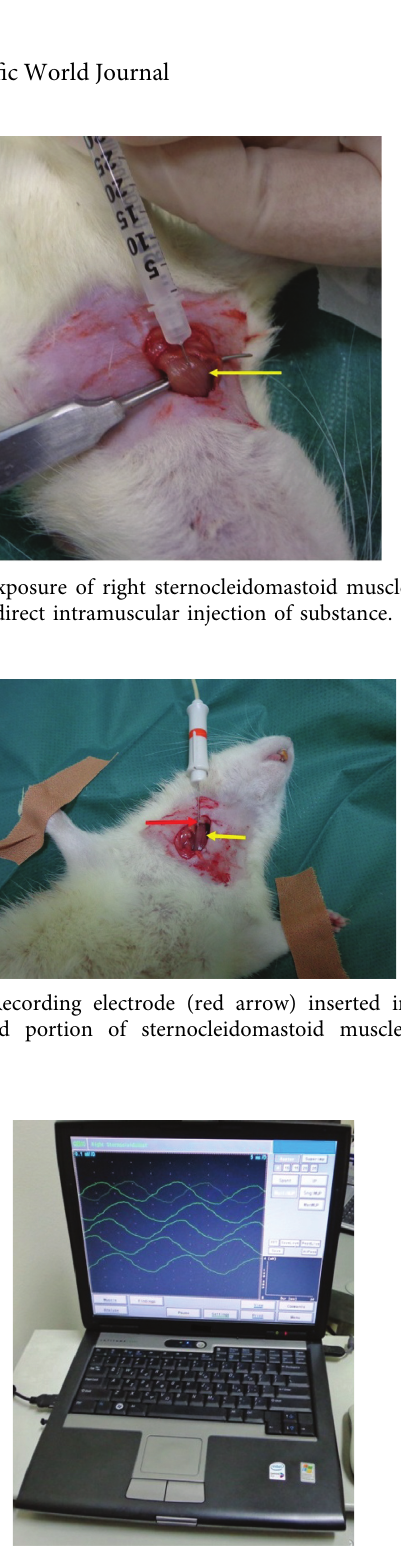
Figure 3: Electromyography equipment, Keypoint device.